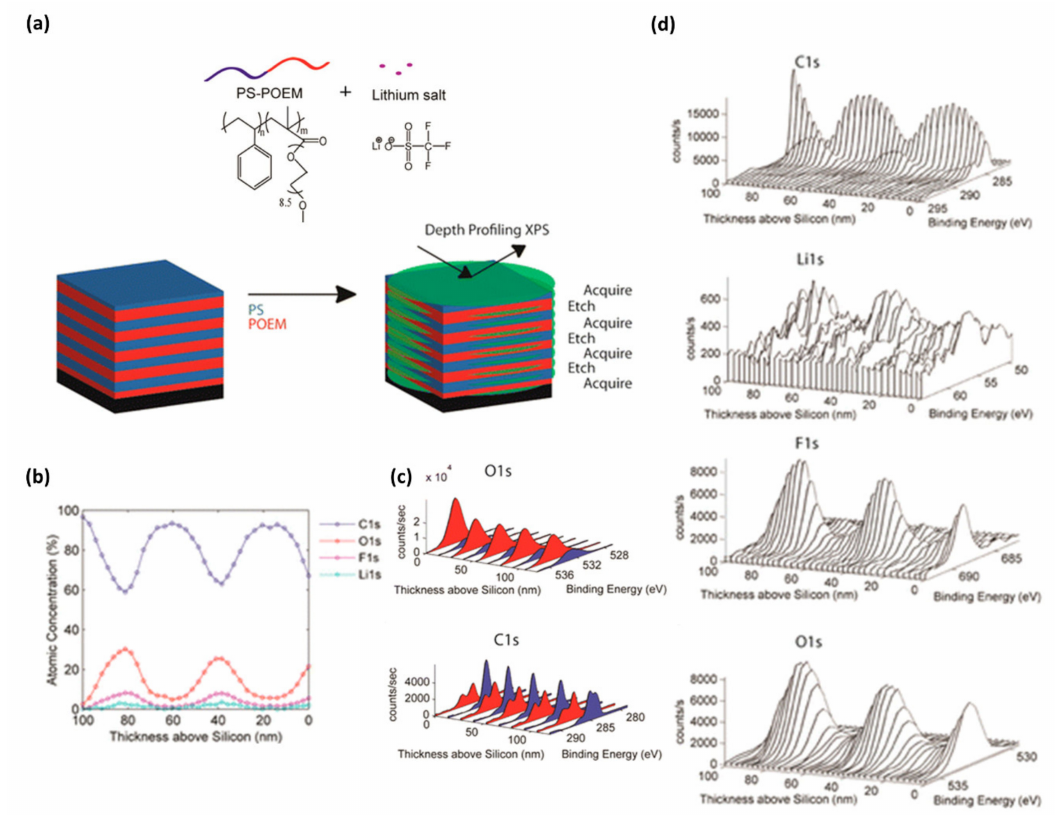
Figure 9. ( a ) Schematic illustration of depth profiling of a lamellae-structured polymer nanocomposite with block copolymers and Li-ions. ( b ) Atomic percentage vs thickness plots of F(1s), C(1s), O(1s), and Li(1s). ( c ) Photoelectron spectra of O(1s), and C(1s). ( d ) Thickness dependent XPS spectra of C(1s), Li(1s), F(1s), and O(1s). (Reproduced with permission from Reference [37]; Copyright (2015) American Chemical